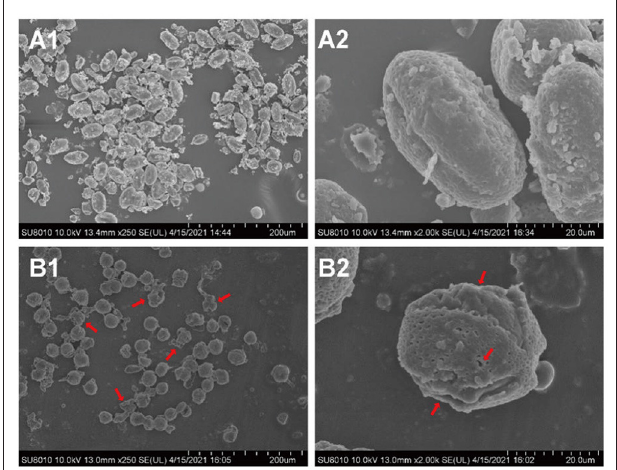
FIGURE 3 | The morphological changes of B. napus bee pollen grains before and after fermentation by S. cerevisiae using scanning electron microscope (SEM). (A1) Unfermented B. napus bee pollen (250 × ). (A2) Single unfermented B. napus bee pollen grain (2000 × ). (B1) Fermented B. napus bee pollen (250 × ). (B2) Single fermented B. napus bee pollen grain (2000 × ). The red arrows indicate the breakage of outer pollen wall and the exposure of intracellular substances through